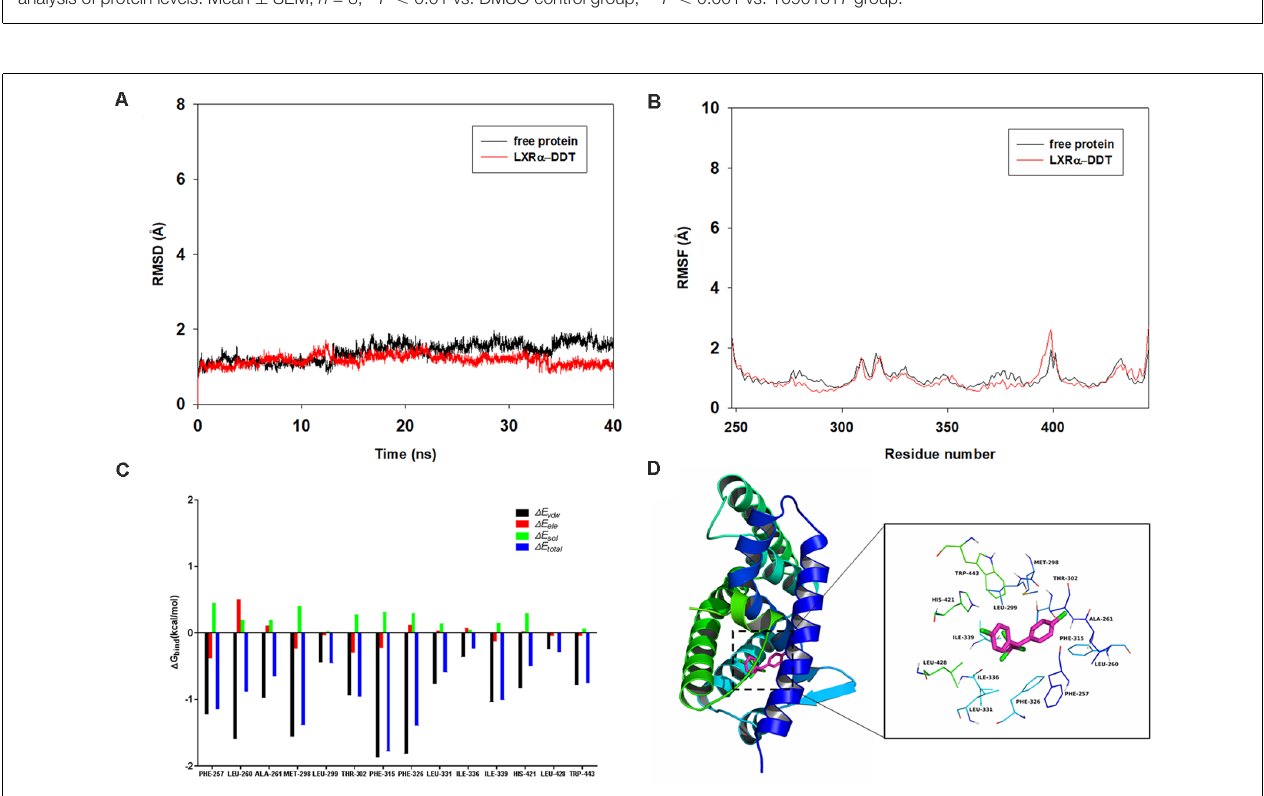
FIGURE 5 | Molecular docking and molecular dynamics simulation indicates LXR α could bind to LXR α protein. (A) The root-mean-square deviations (RMSD) of all the atoms of the LXR α -DDT complex with respect to its initial structure as a function of time. (B) The root-mean-square fluctuations (RMSF) of residues of the whole protein in the LXR α -DDT complex and free LXR α during the 40-ns simulation. (C) Decomposition of the binding energy on a per-residue basis in the LXR α -DDT complex. (D) The predicted binding mode of DDT in LXR α binding pocket obtained from molecular dynamics